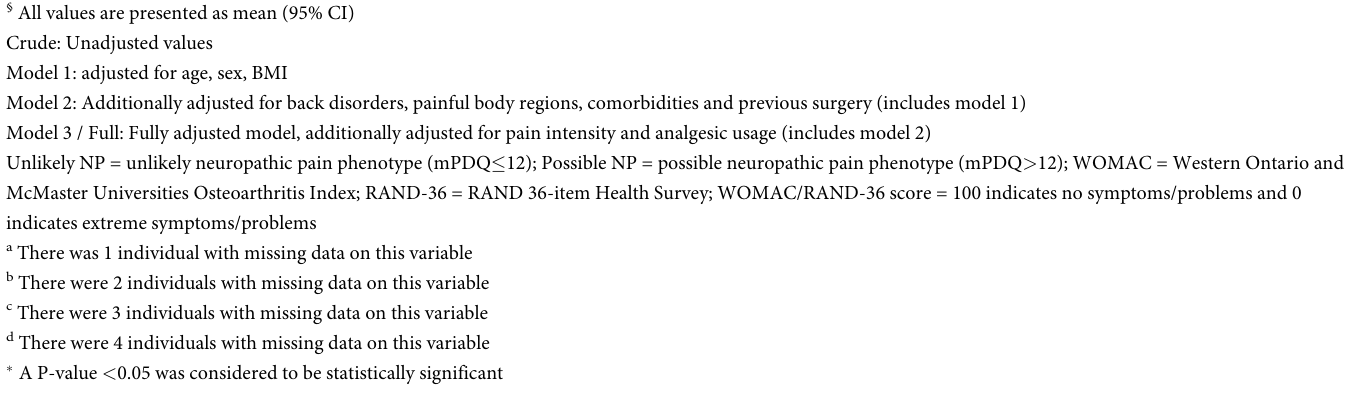
analgesic usage (model 3) reduced contrasts between the two phenotypes, from around 20 points (model 2) to around 10 points (model 3). Differences remained statistically significant on all WOMAC domains (Fig 3, Table 3). Health-related quality of life (RAND-36). The crude data displayed two domains in which the two pain phenotypes (unlikely versus possible NP) significantly differed, namely the physical functioning domain (18.5 points) and the role-physical domain (15.4 points). Basic